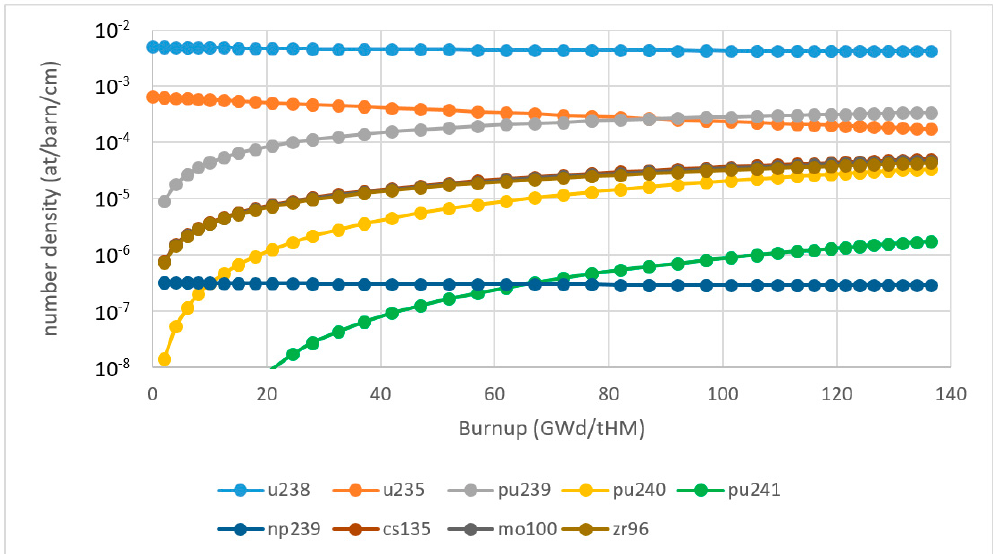
Figure 10. Criticality over burnup for the temperature varied system with the criticality given on the left axis and the system averaged temperature on the right axis for the heavy metal rich system .